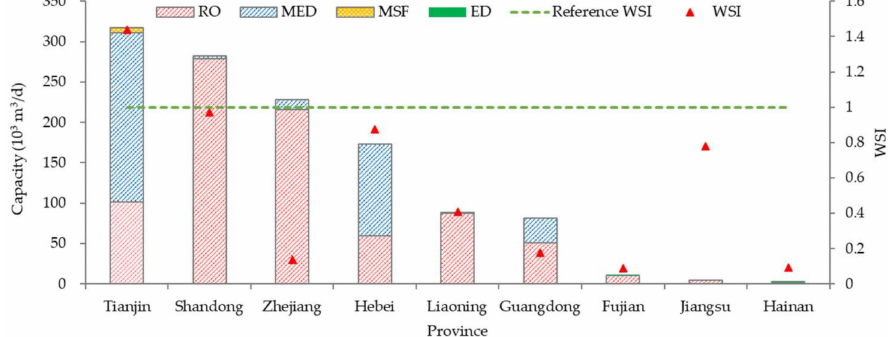
Figure 4. Water desalination capacity by provinces (derived from [14]). WSI: water stress index, RO: reverse osmosis; MED: multiple-effect distillation; MSF: multi-stage flash; ED: